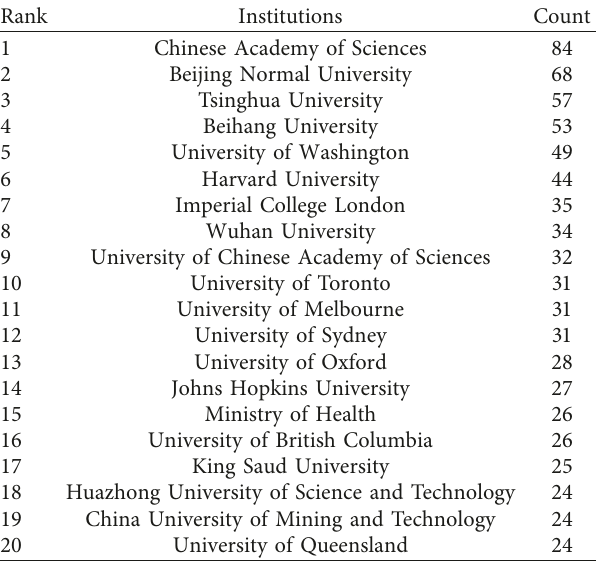
Table 3: Top 20 institutions in the number of papers of interna- tional DEM